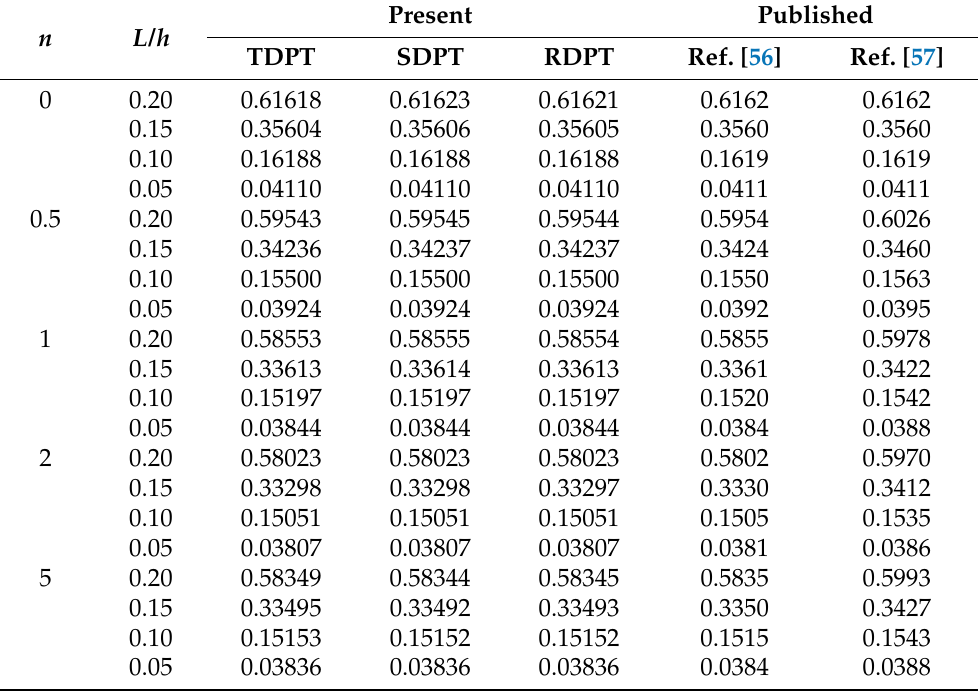
Table 4. Comparison of nondimensional frequency ˆ Ω of FG plate resting on Pasternak elastic foundation ( J 1 = 100, J 2 =